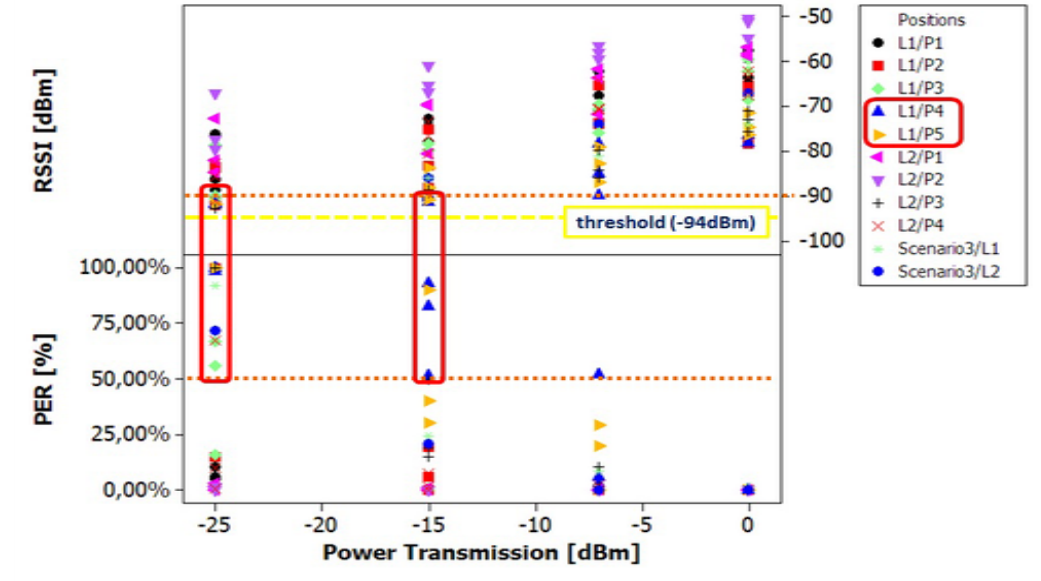
Figure 10. One-way ANOVA: RSSI, PER vs . Power